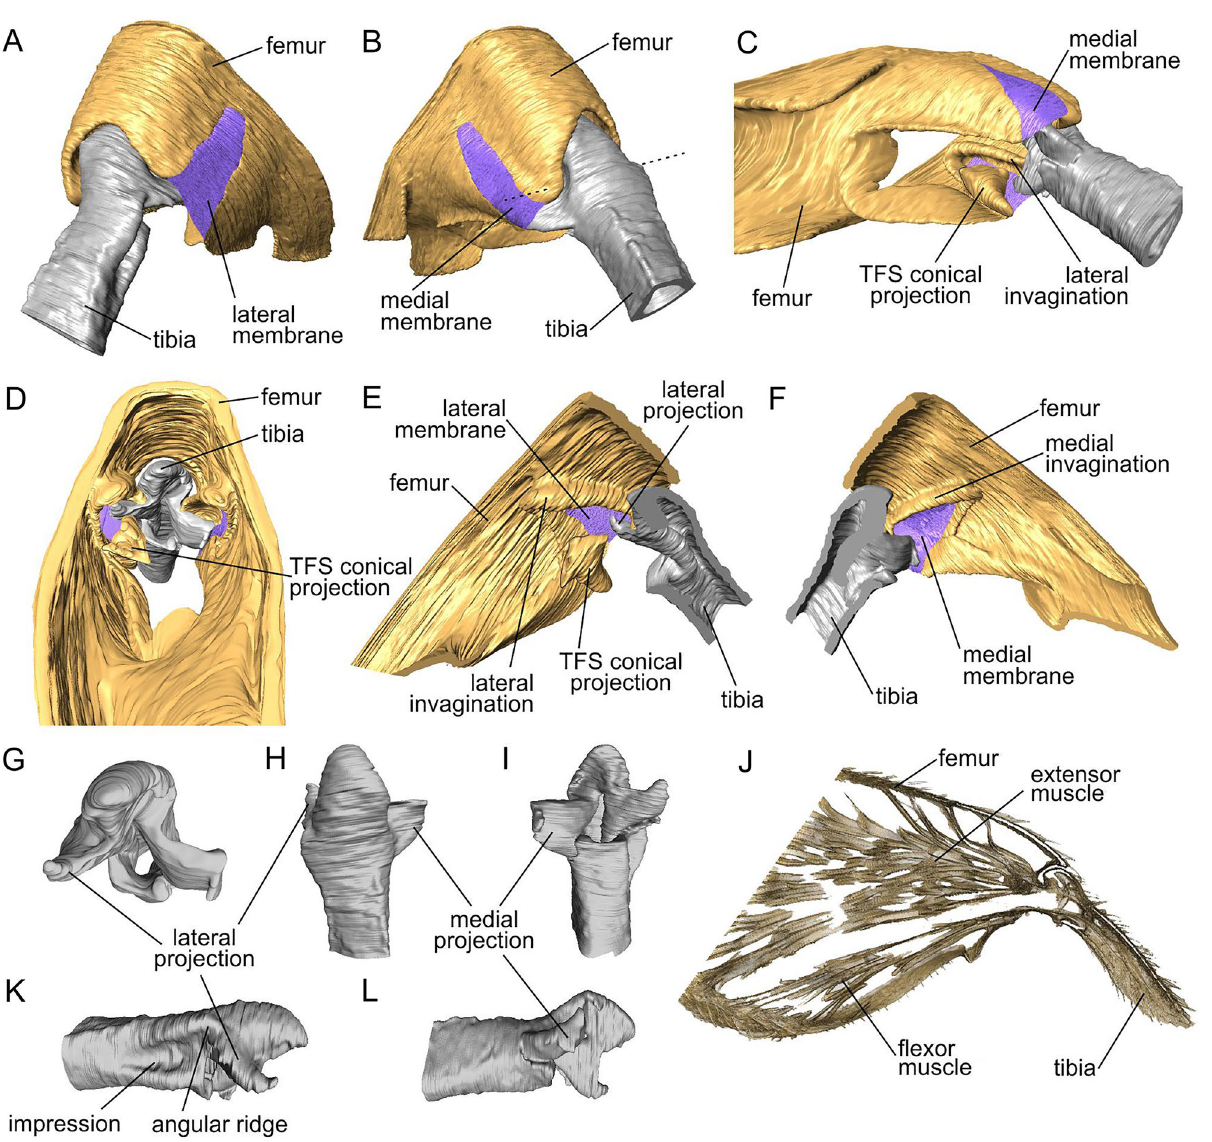
Figure 3. Femoro-tibial joint of the hind jumping leg of Scirtes hemisphaericus , synchrotron X-ray micro- computed tomography (SR-µCT). ( A , B ) Femoro-tibial joint, antero-lateral view, dashed line shows the axis of rotation. ( C ) Femoro-tibial joint, ventral view. ( D ) Femur, transversal section proximally to the femoro-tibial joint. ( E , F ) Femoro-tibal joint, sagittal section. ( G – I , K , L ) Tibial base: ( G ) posterior view; ( H ) dorsal view; ( I ) ventral view; ( K , L ) lateral view. ( J ) Muscular system of the femur, SR-µCT data volume reconstruction, semi- thin sagittal section. TFS tibial flexor